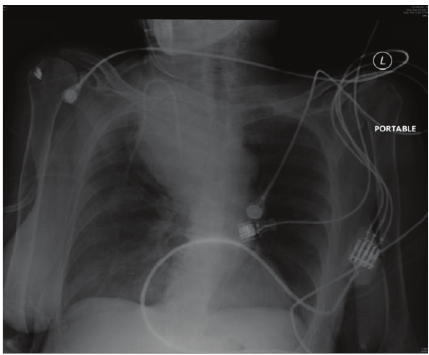
Figure 3: Postprocedural chest X-ray showing right mediastinal hematoma. Thoracic and vascular surgery team was consulted immediately and the decision was made to emergently take the patient to the operating room for evacuation of a mediastinal hematoma. Central and arterial access was obtained and transfusion of packed red blood cells (PRBC) was started. The hemodynamic status